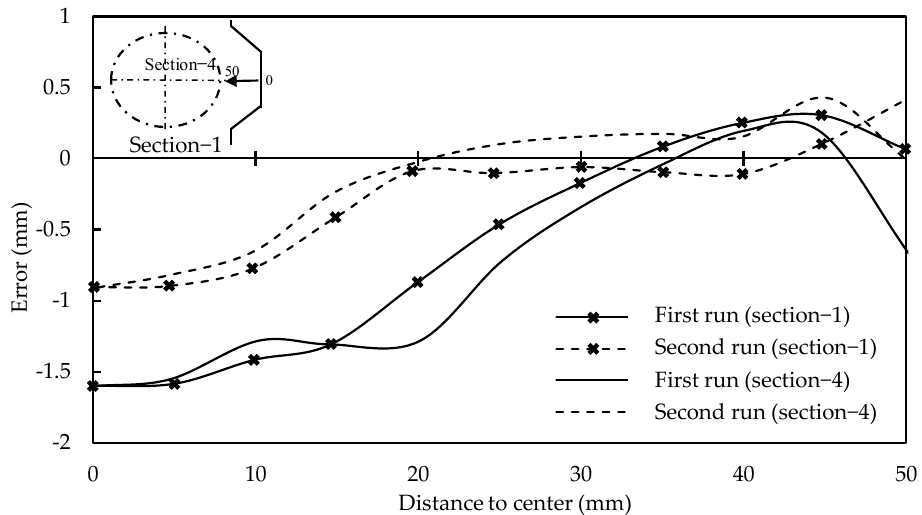
Figure 12. Accuracy comparison at different sections at first run (with-out compensations) and second run (with compensations), (reprinted with permission from Meier et al. [47], Copyright 2009 Elsevier).